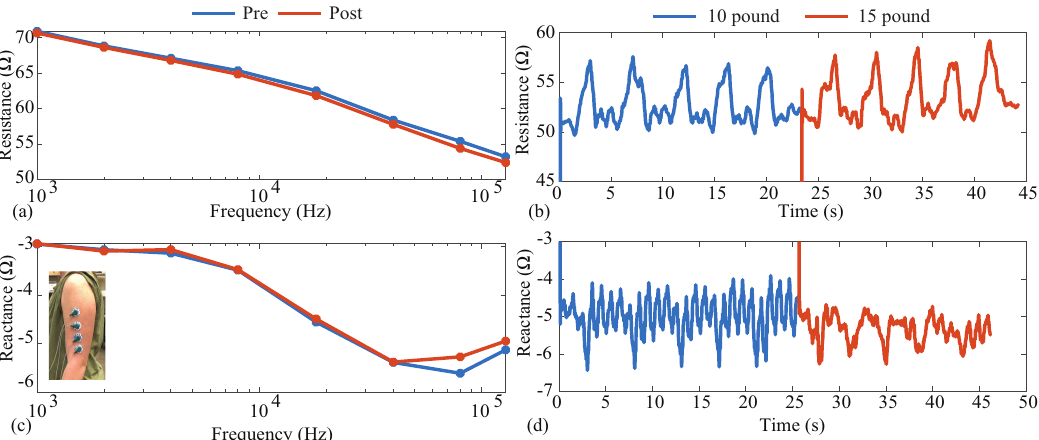
Figure 13. ( a , b ) Resistance and ( c , d ) reactance measurements of localized bicep tissues collected before/after (multi- frequency, 1 to 128 kHz) and throughout (single frequency, 128 kHz) an activity protocol of dumbbell bicep